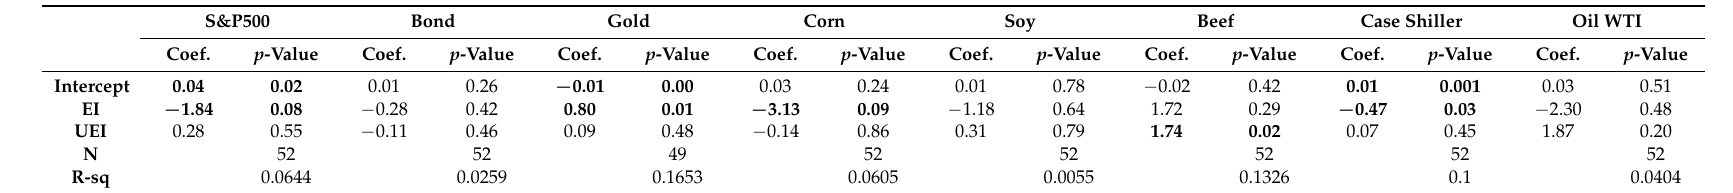
Table 7. Regression results: expected and unexpected inflation, indexes, September 2011 to December